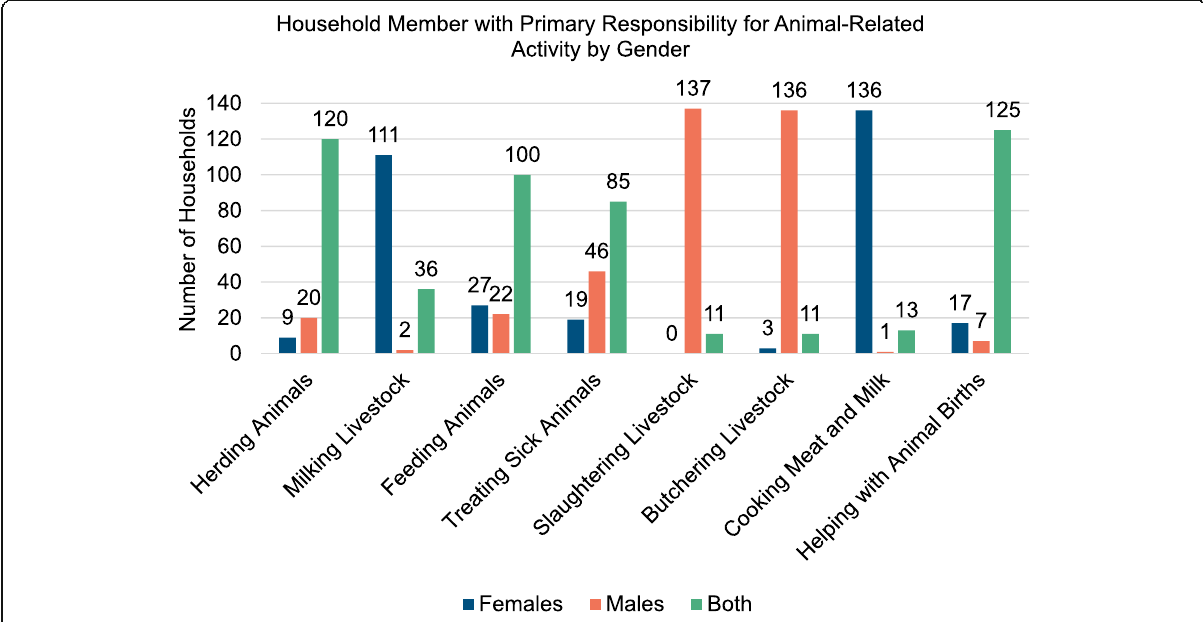
Fig. 3 Gender of the household member with reported responsibilities for animal care among herding families of rural